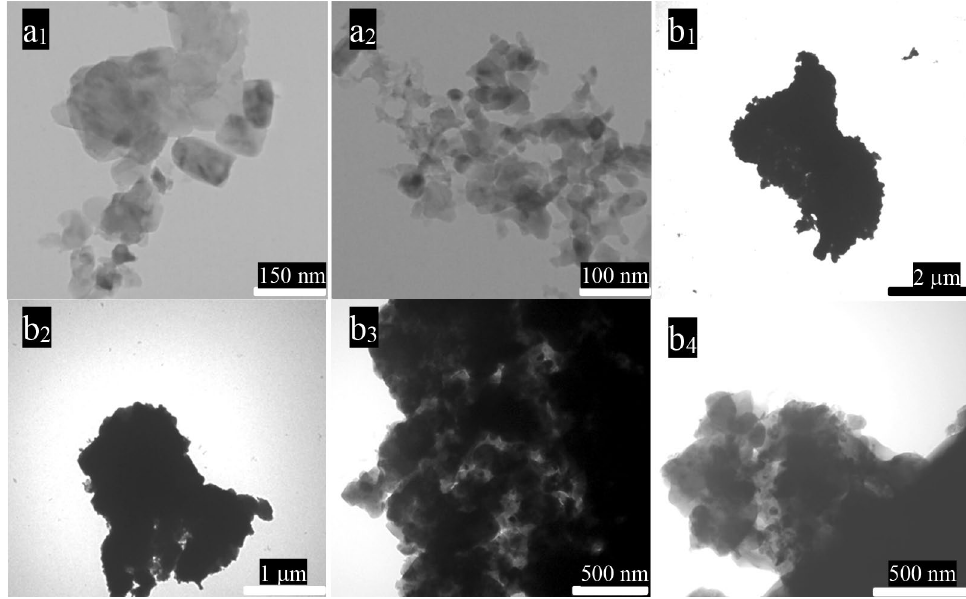
Figure 4. TEM images of CuCo 2 S 4 ( a 1 , a 2 ) and FCMT/CuCo 2 S 4 ( b 1 – b 4 ) nanostructures.